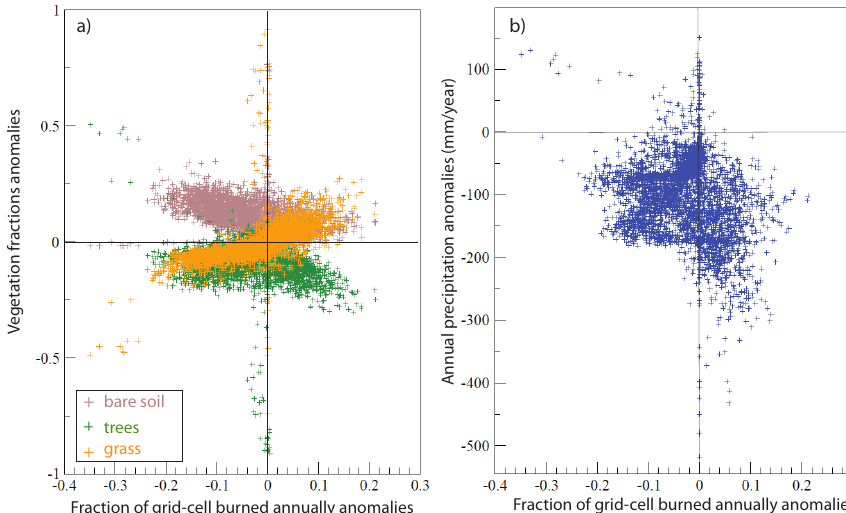
Figure 13. (a) Anomalies in the fraction of a grid cell occupied by bare soil (brown), trees (green), grasses (yellow) vs. anomalies in the percentage of a grid cell burned annually (MIS4_min–MIS4_max). (b) Total annual precipitation anomalies (mmyr − 1 ) vs. anomalies in the percentage of a grid cell burned annually